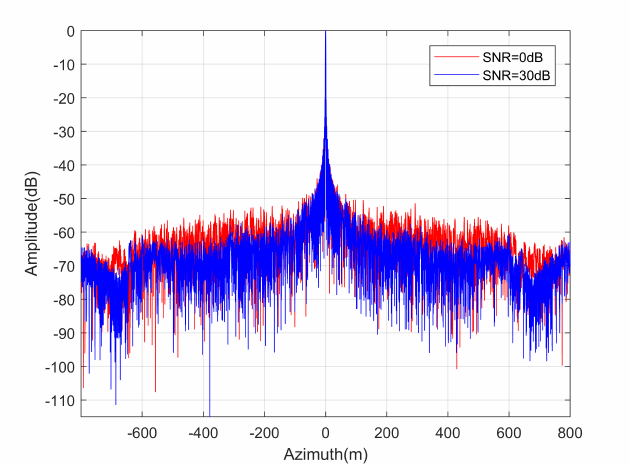
Figure 13. The relationship between the image quality indicators of the reconstruction and the signal- to-noise ratio (SNR). ( a ) The relationship between the image entropy and SNR; ( b ) the relationship between the AASR and SNR.